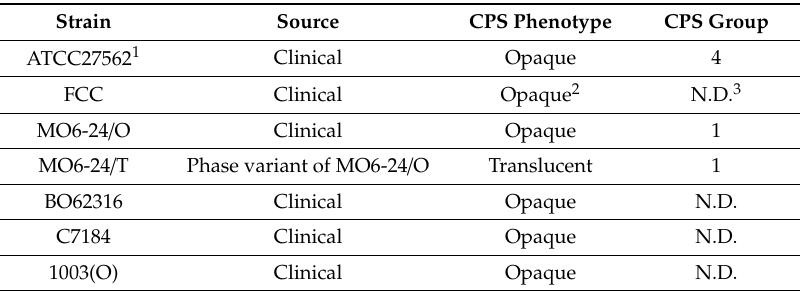
Table 1. V. vulnificus strains discussed in this